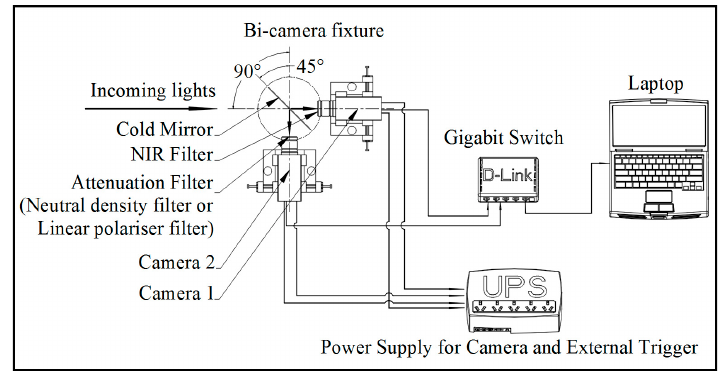
Figure 1. Assembly for citrus fruit image acquisition.